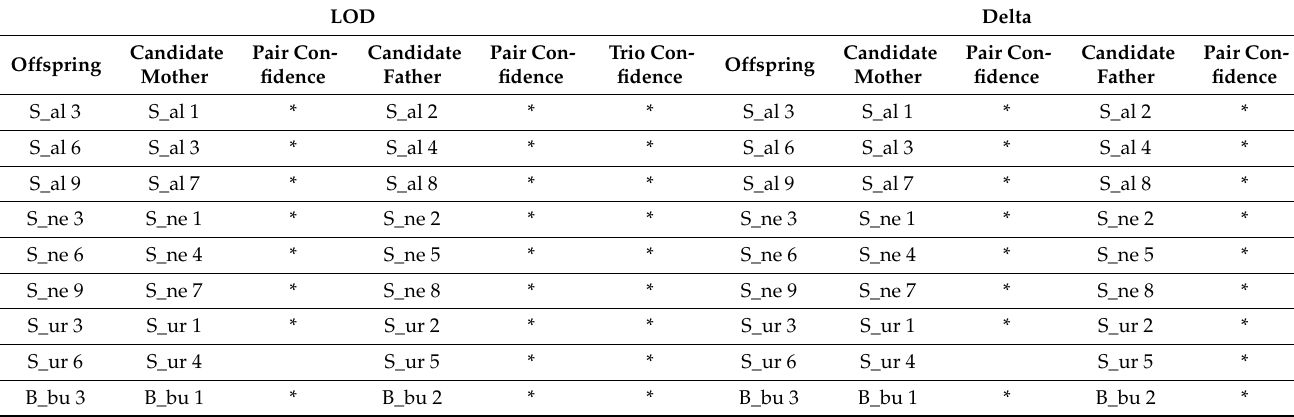
Table 6. Parentage analysis in Cervus using the LOD and Delta computation. The different confidence values are indicated by the following codes: * = confidence level higher than 95%. In the table, misallocation or low assignment probabilities are highlighted in